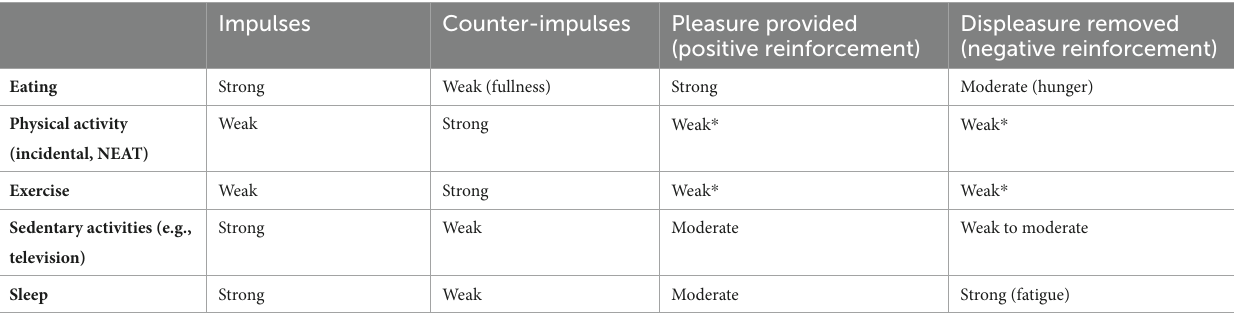
TABLE 2 The relative imbalance of impulses and counter-impulses (i.e., internal nudges and brakes/constraints) to either promote or stop eating, physical activity, sedentary, and sleep behaviors (typically observed across the adult population), as varying in strength by hedonic